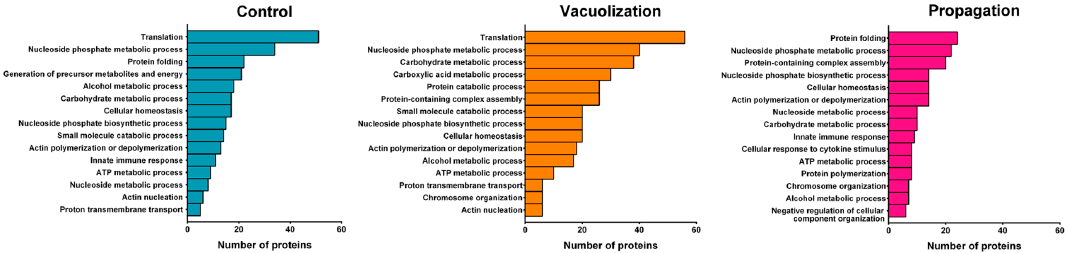
Figure 4. Classification of SHK-1 proteins in most represented Gene ontology (GO) terms. All proteins in control, vacuolization stage, and propagation stage were classified based on GO annotation of SHK-1 proteome, and the 15 most representative biological processes GO terms are shown. The number of proteins in each category for all identified proteins in the three conditions is shown in the bar graph.